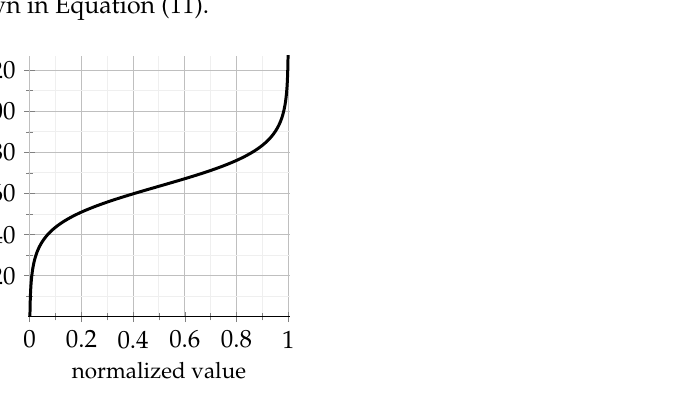
Figure 3. Conversion of normalized values ∈ [ 0,1 ] to human-readable midipitch values ∈ [ 0,127 ]